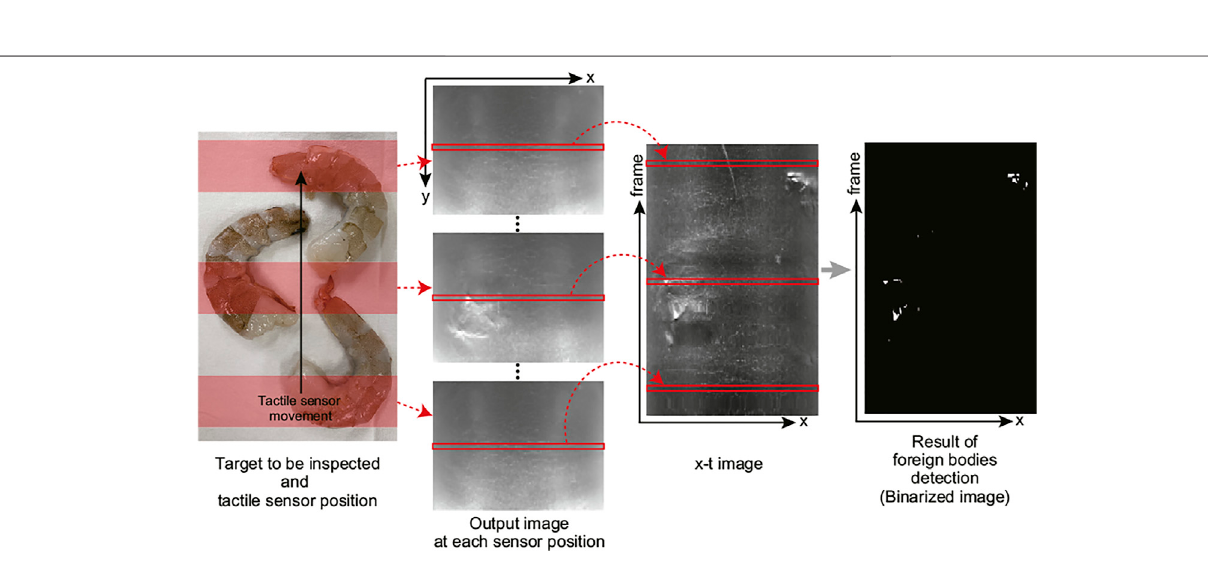
Frontiers in Robotics and AI |